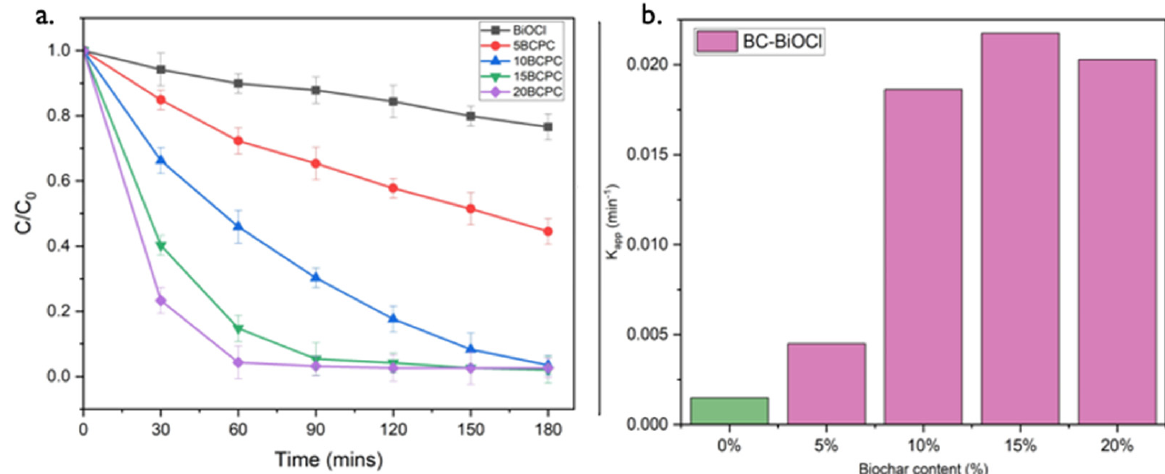
Figure 9. The photo-assisted removal evolution of MO (30 mg/L) using pristine BiOCl (1 g/L) and its composites with different amounts of lignin-derived biochar ( a ) and the apparent rate constants of the MO removal ( b ) under UV light irradiation.